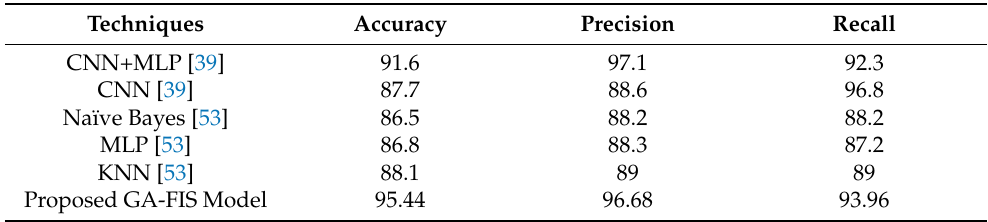
Table 11. Comparison of the proposed model with existing smart garbage